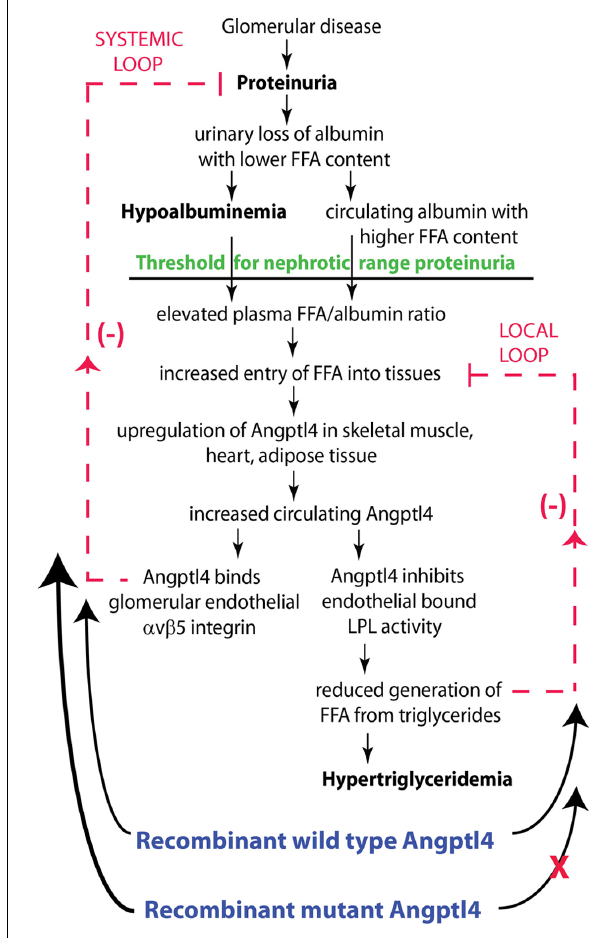
FIGURE 4 | Schematic illustration of negative feedback loops in the link between proteinuria, hypoalbuminemia and hypertriglyceridemia mediated byAngptl4 and FFA (free fatty acids). Plasma FFA are non-covalently bound to albumin, and because of the preferential loss of albumin with low FFA content during proteinuria, albumin with higher FFA content is retained in circulation. As glomerular disease progresses and proteinuria increases, hypoalbuminemia develops, and the combination of high albumin FFA content and lower plasma albumin levels increases the plasma FFA/albumin ratio.This increased available FFA enters skeletal muscle, heart and adipose tissue to induce upregulation of Angptl4, at least in part mediated by PPARs. Angptl4 secreted from these organs participates in two feedback loops. In the systemic loop, it binds to glomerular endothelial α v β 5 integrin and reduces proteinuria, the principal driver of nephrotic syndrome. In a local loop, it inhibits LPL activity in the same organs from which it is secreted to reduce the uptake of FFA, thereby curtailing the stimulus for its own upregulation. Exogenously administered recombinant wild type Angptl4 affects both loops, similar to endogenous Angptl4, thereby reducing proteinuria and increasing plasma triglyceride levels. Recombinant mutant forms of Angptl4 bypass the local loop, and act only on the systemic loop, thereby reducing proteinuria without raising plasma triglyceride levels. Adapted from Clement etal.